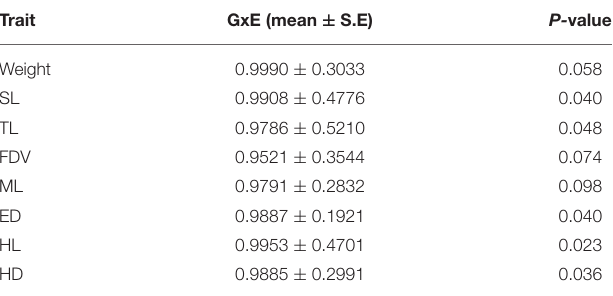
W, weight; SL, standard length; TL, total length; FDV, fin depth at vent; ED, eye diameter; ML, mandible length; HL, head length; HD, head depth. traits in juvenile yellowtail kingfish at 21 dph exhibit low, but statistically significant heritabilities under current day